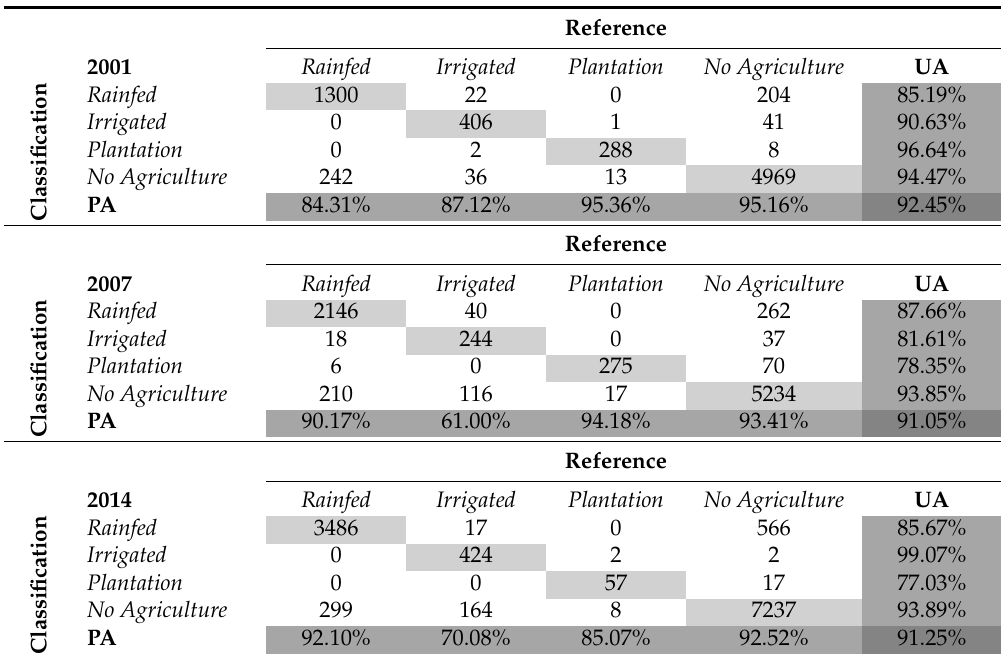
Table 4. Confusion matrices indicating overall accuracies as well as user’s (UA) and producer’s accuracies (PA) for each agricultural class in percent for the years 2001 ( top ), 2007 ( middle ), and 2014 ( bottom